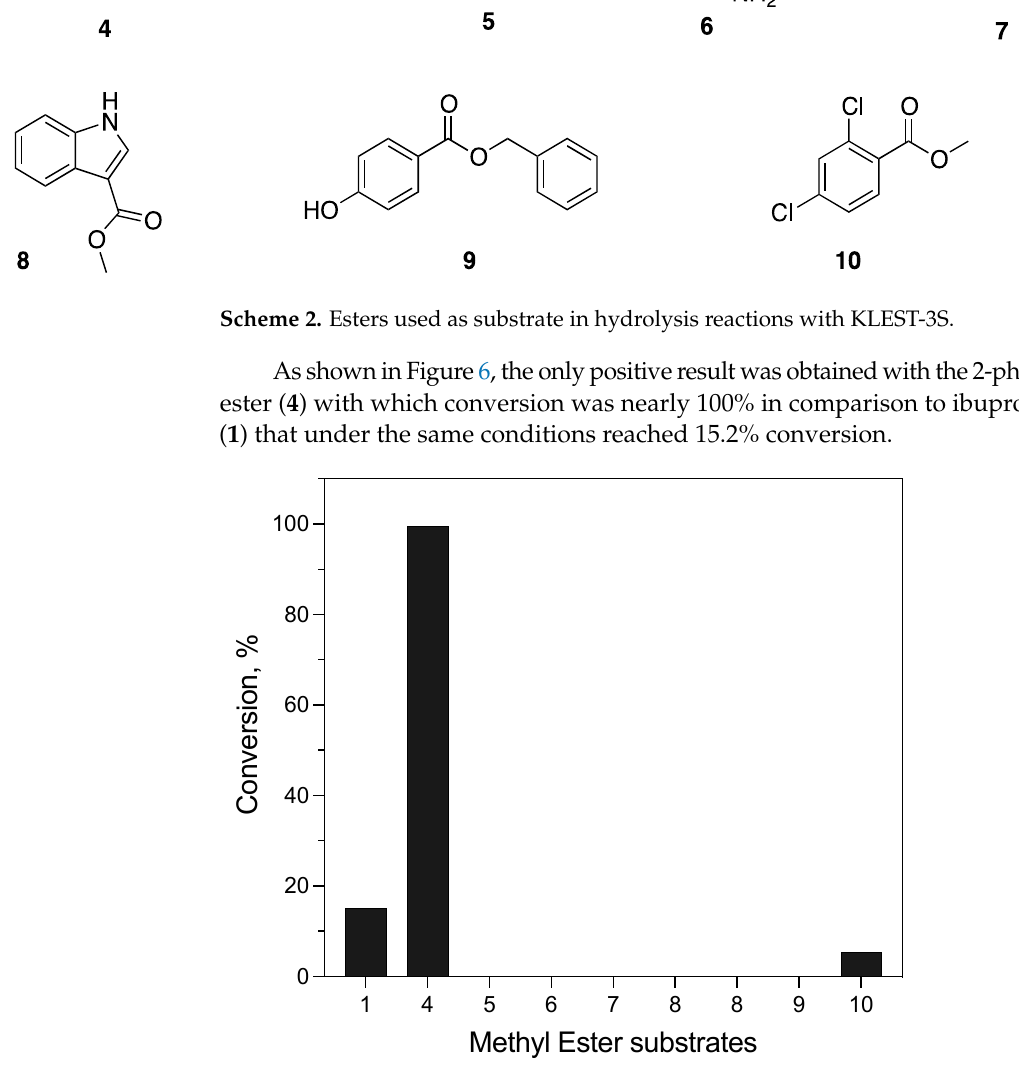
Figure 6. Hydrolysis of different esters to corresponding acid. Reaction time, 24 h; temperature, 65 °C; Cosolvent, 10% ( v / v ) DMF; KLEST-3S, 8.5 Units (measured with pNP C12 with the standard method).